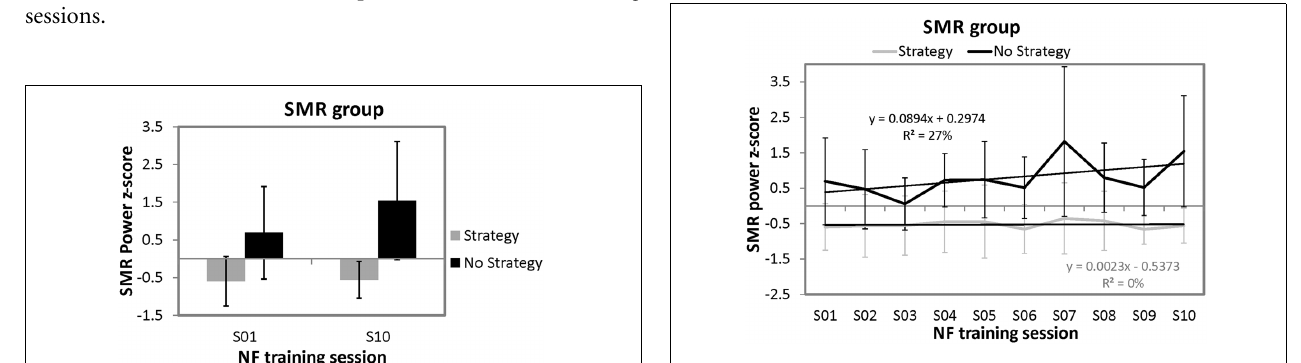
FIGURE 2 | Means and standard deviations of z -transformed SMR power (12–15Hz) values during the first and tenth NF training session, presented separately for participants reporting to use a specific mental strategy in the tenth NF session (strategy group) and participants reporting no specific mental strategy in the tenth NF session (no strategy group).